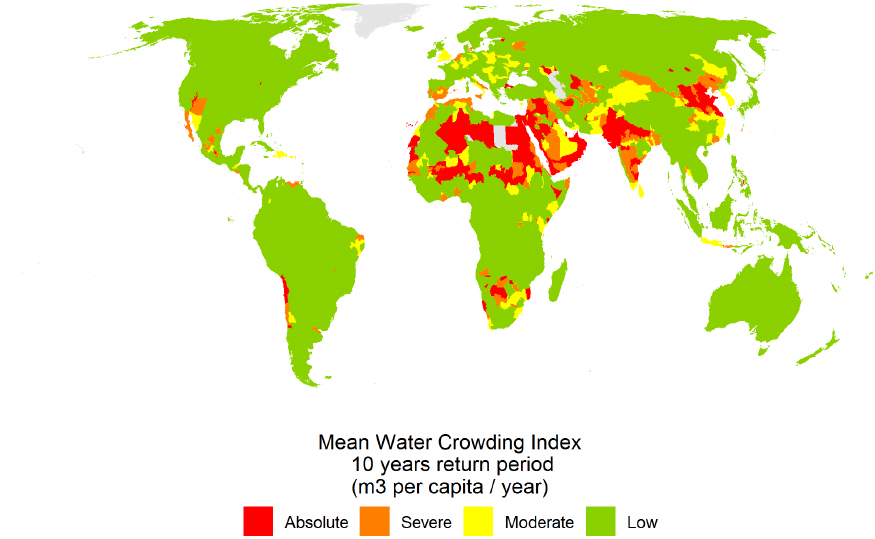
Figure A2. Water Scarcity Index categories with a return period of 10 years (Veldkamp et al., 2015).